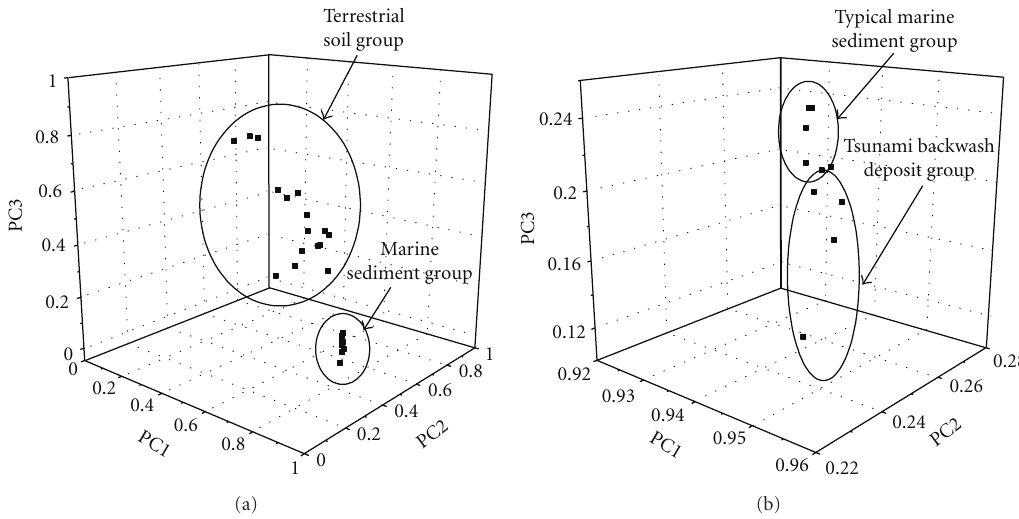
Figure 5: Three dimensional plots of principal component 1 (PC1), principal component 2 (PC2), and principal component 3 (PC3) of sulfur K-edge XANES spectrum of typical marine sediments (TMS), tsunami backwash deposits (TBD), and German terrestrial soils